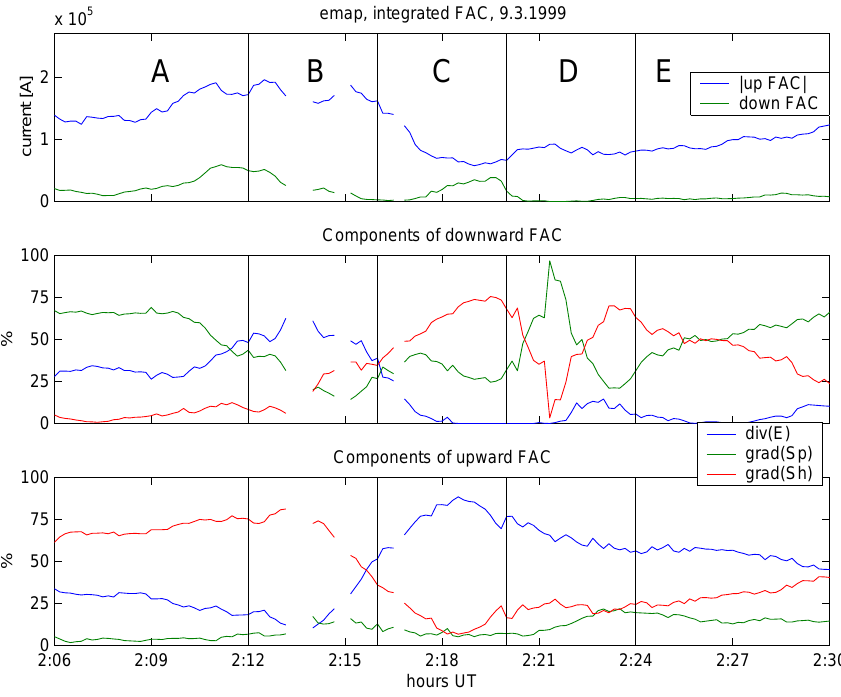
Fig. 12. Time series of the upward and downward FAC integrated over the emap data area, together with contributions from the different terms of ∇· J . The upper panel gives the total upward and downward FAC. Middle panel shows the relative importance of the different components for the downward FAC, while bottom panel shows component of the upward FAC in similar manner. The vertical lines indicate the (approximate) intervals when different regions of the omega-band cross the analysis area, A: trailing edge of the previous tongue, B: dark region between the tongues, C: leading edge of the second auroral tongue, D: auroral tongue, E: trailing edge of the second